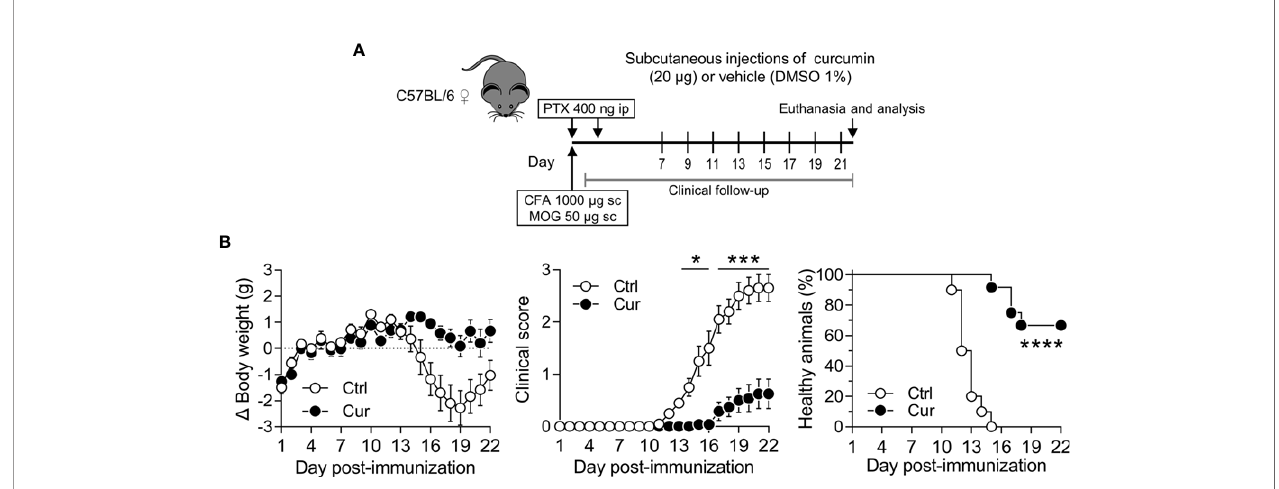
FIGURE 6 | Microdose curcumin is also neuroprotective on a therapeutic scheme of administration. (A) WT C57BL/6 female mice were MOG-immunized and treated ip with PTX to induce EAE. From day 7 until the end of the experiment (day 22), mice received sc curcumin (Cur) or vehicle (Ctrl) every other day. Clinical follow-up was performed daily during the length of the experiment. (B) Changes in body weight (left), clinical score (center) and percentage of healthy animals (right) were recorded daily after immunization. Data is presented as the mean ± SEM and a two-way ANOVA for repeated measures with Bonferroni ’ s post-test was carried out ( B , left and center). Percentage of healthy animals was plotted as a Kaplan-Meier curve and a Mantel-Cox test was performed ( B , right). n=11 animals per group. *P < 0.05; ***P < 0.001; ****P <